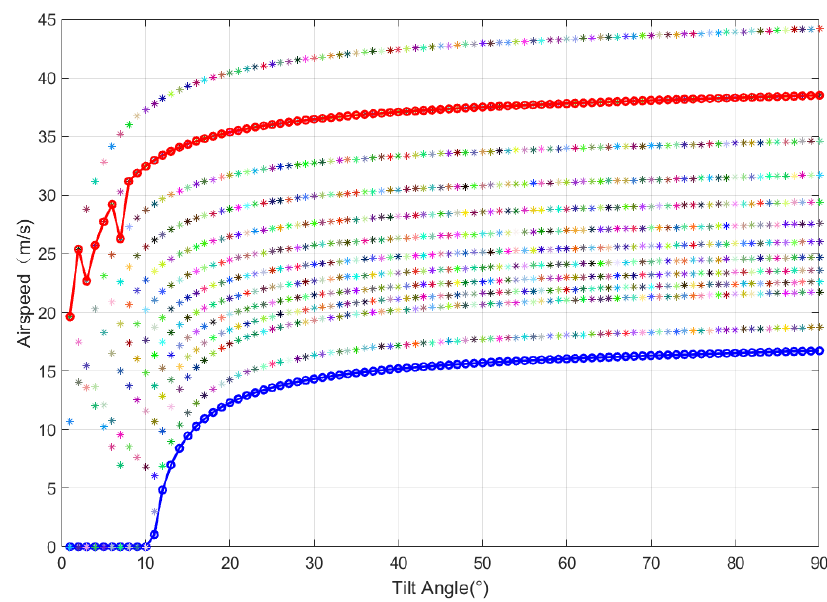
Figure 5. The boundary of the tilting corridor.